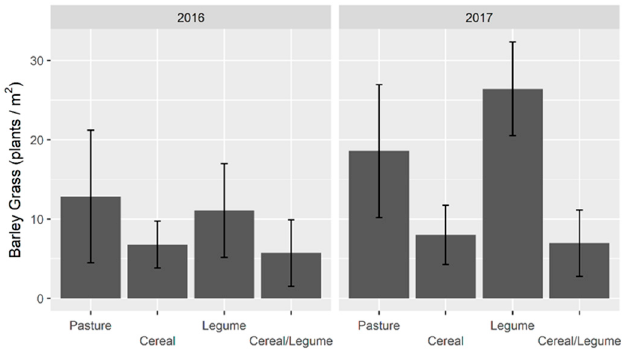
Figure 2. Barley grass seedling density (plants/m 2 ) in winter. forage crops grown in 2015–2017 at Wagga Wagga, NSW. Data displayed as the mean ± 2 × standard error (length of line in each direction).